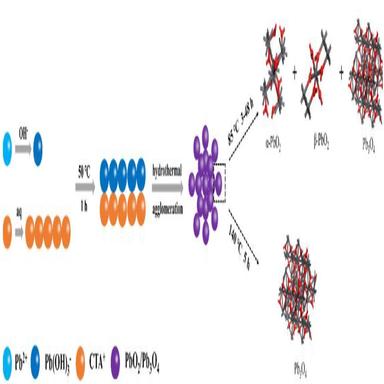
Proposed schematic illustration of synthesizing electro-catalysts.